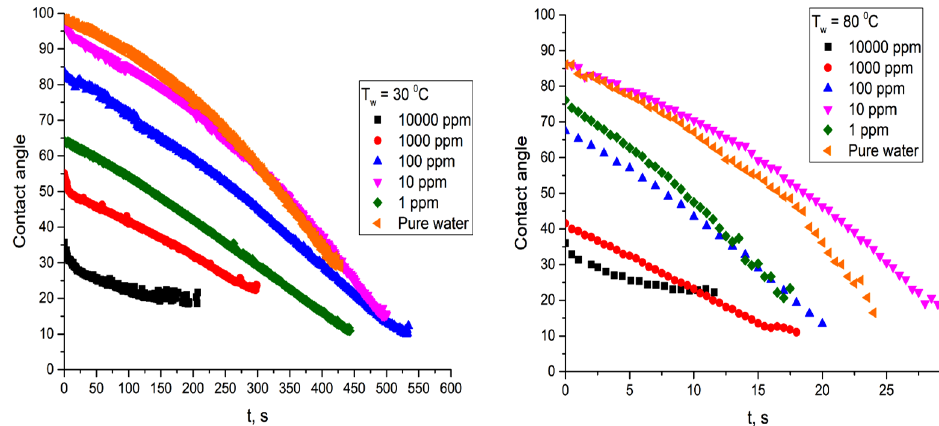
Figure 5. Evolution of contact angle over time of evaporation.